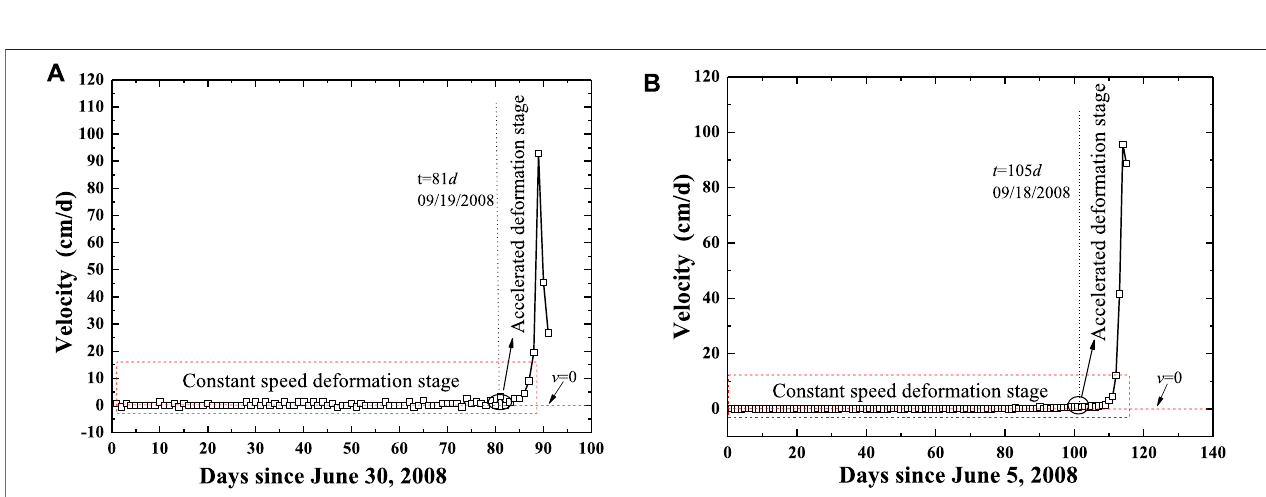
FIGURE6| Relationshipsbetweenvelocityandtimeat the depthof4.8and 3.7 mbased onthe deep displacement datacollected by (A) 4#SAAand (B) 5#SAA, respectively (Modi fi ed from Danisch, 2015).